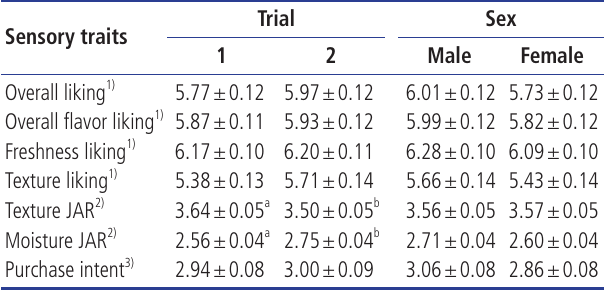
Table 3. Least square means and standard errors of sensory traits evaluating meat from Berkshire crossbreds sired by Hereford boars Sensory traits